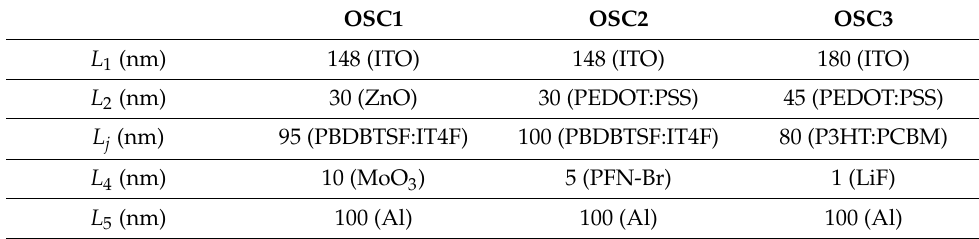
Table 2. Optimised layer thickness for all three